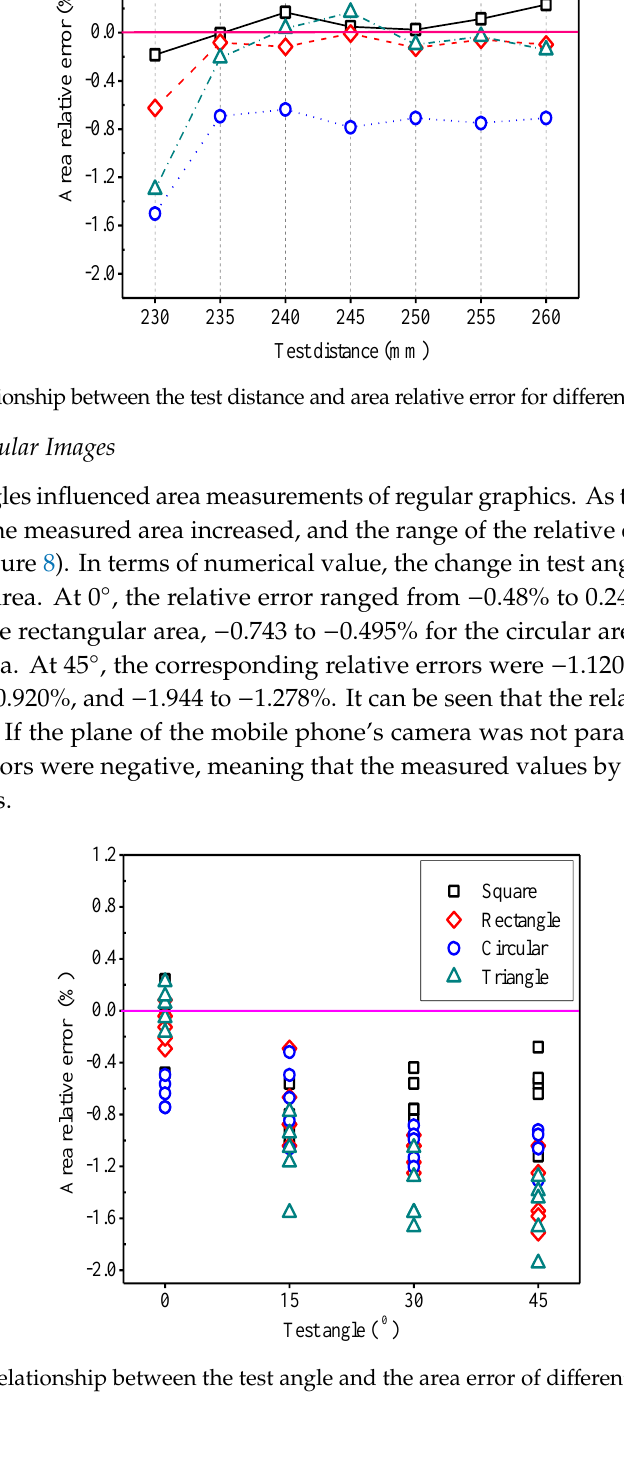
Figure 8. The relationship between the test angle and the area error of different shape